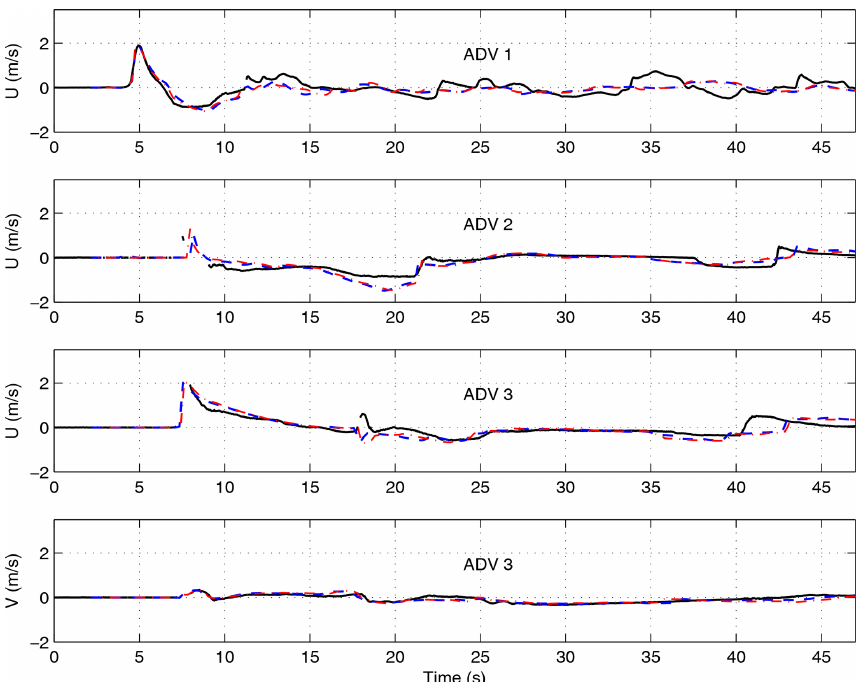
Figure 14. Case of Fig. 11. Comparison of velocities at ADV locations in (solid) experiments and (blue and red dashed, respectively) results of the present nested and original FUNWAVE-TVD